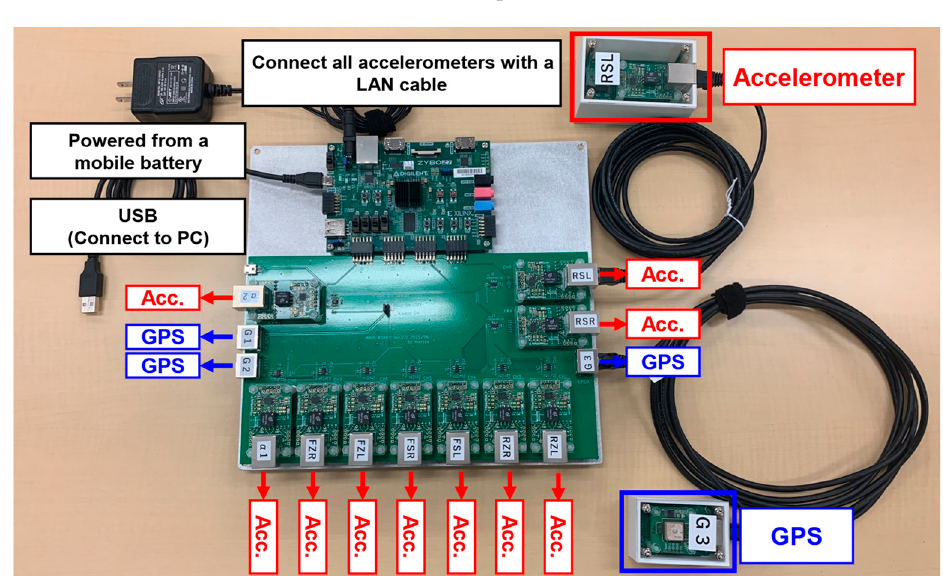
Figure 2. Vehicle measurement sensor system used for measurement.